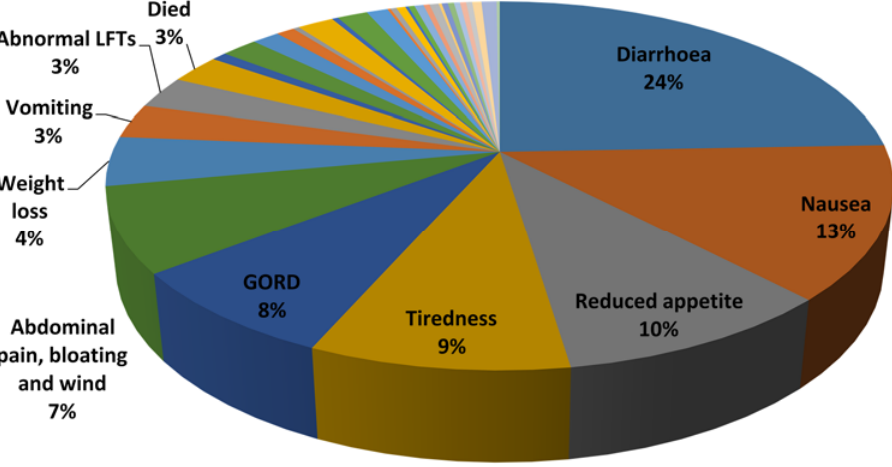
Figure 6. Frequency of Adverse Events with Nintedanib. Table 2. Frequency of Adverse Events with Nintedanib Compared to INPULSIS Clinical Trials.